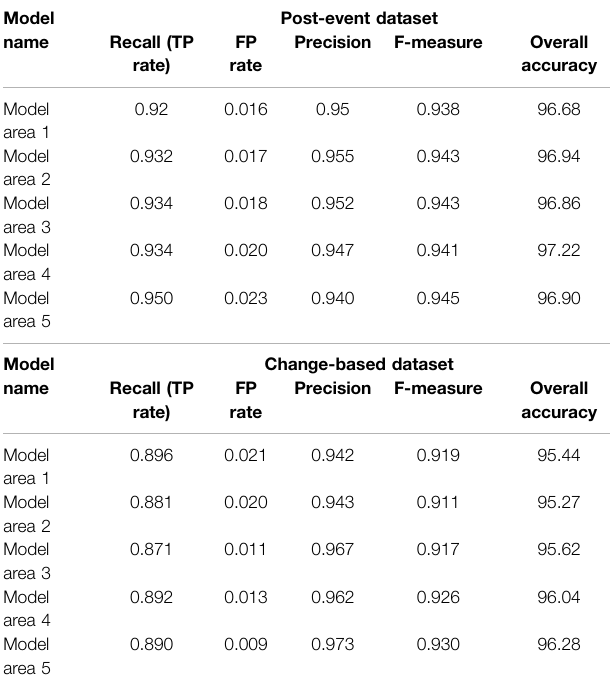
TABLE5| AccuracyassessmentonthetestareawithRFclassi fi ersdevelopedfor model areas. Model